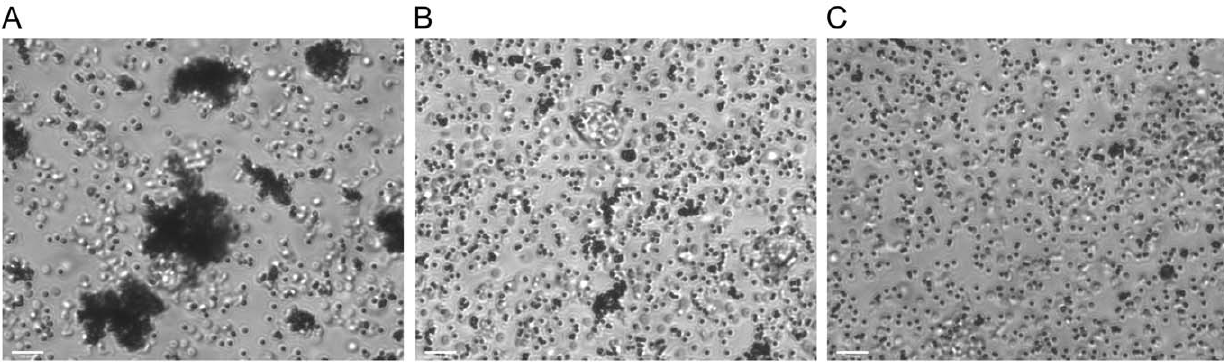
Figure 5. Interaction of biotinylated aptamer coated streptavidin paramagnetic beads with T.cruzi trypomastigotes. Streptavidin beads coated with 100 nM of biotinylated Apt68 or the scrambled control aptamer, Apt68 Sc, or plain beads were incubated with trypomastigotes in SELEX buffer. Aggregates of beads bound to parasites were observed only in the presence of Apt68 coated beads and trypomastigotes (A). Scrambled aptamer (Apt68 Sc) coated beads (B) or beads alone (C) did not cause aggregation when incubated with trypomastigotes.